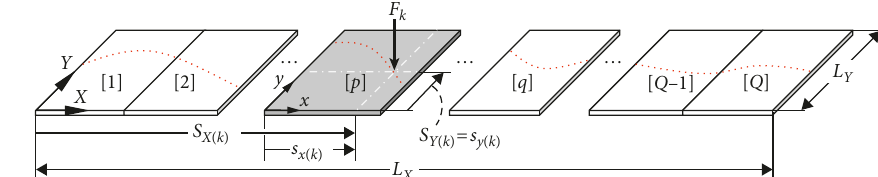
k acting on the p -th span.